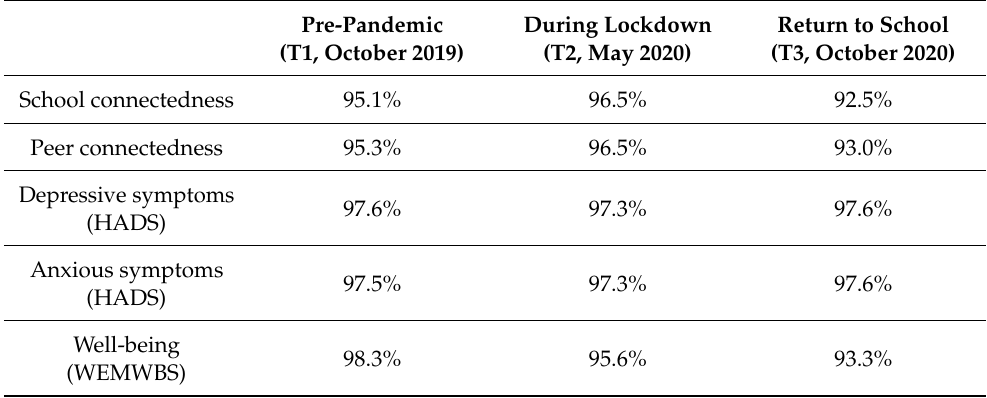
Table 2. Percentage of participants with complete data on exposure predictor and outcome measures by survey time